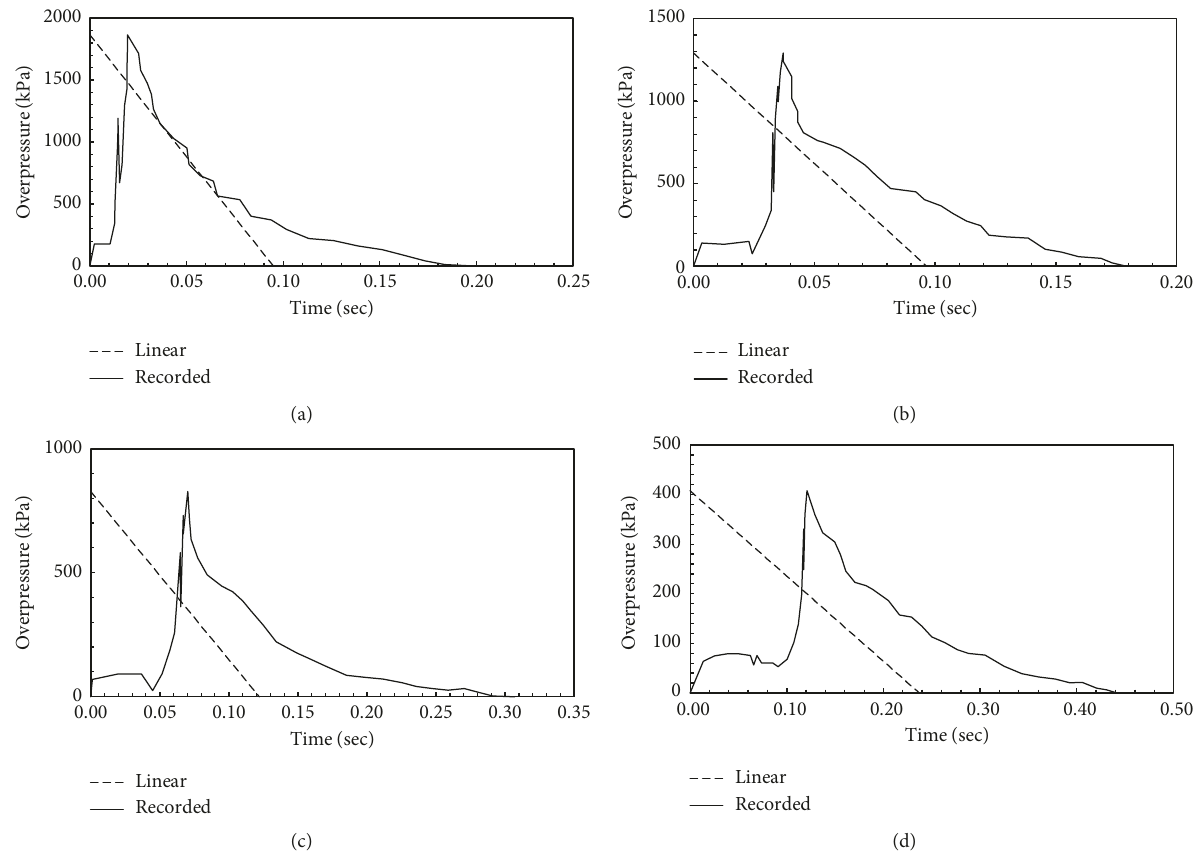
Figure 4: Measured and equivalent (linear) overpressure time-histories for shot Priscilla at stations (a) P1, (b) P2, (c) P3, and (d) P4 (measured overpressure time-histories